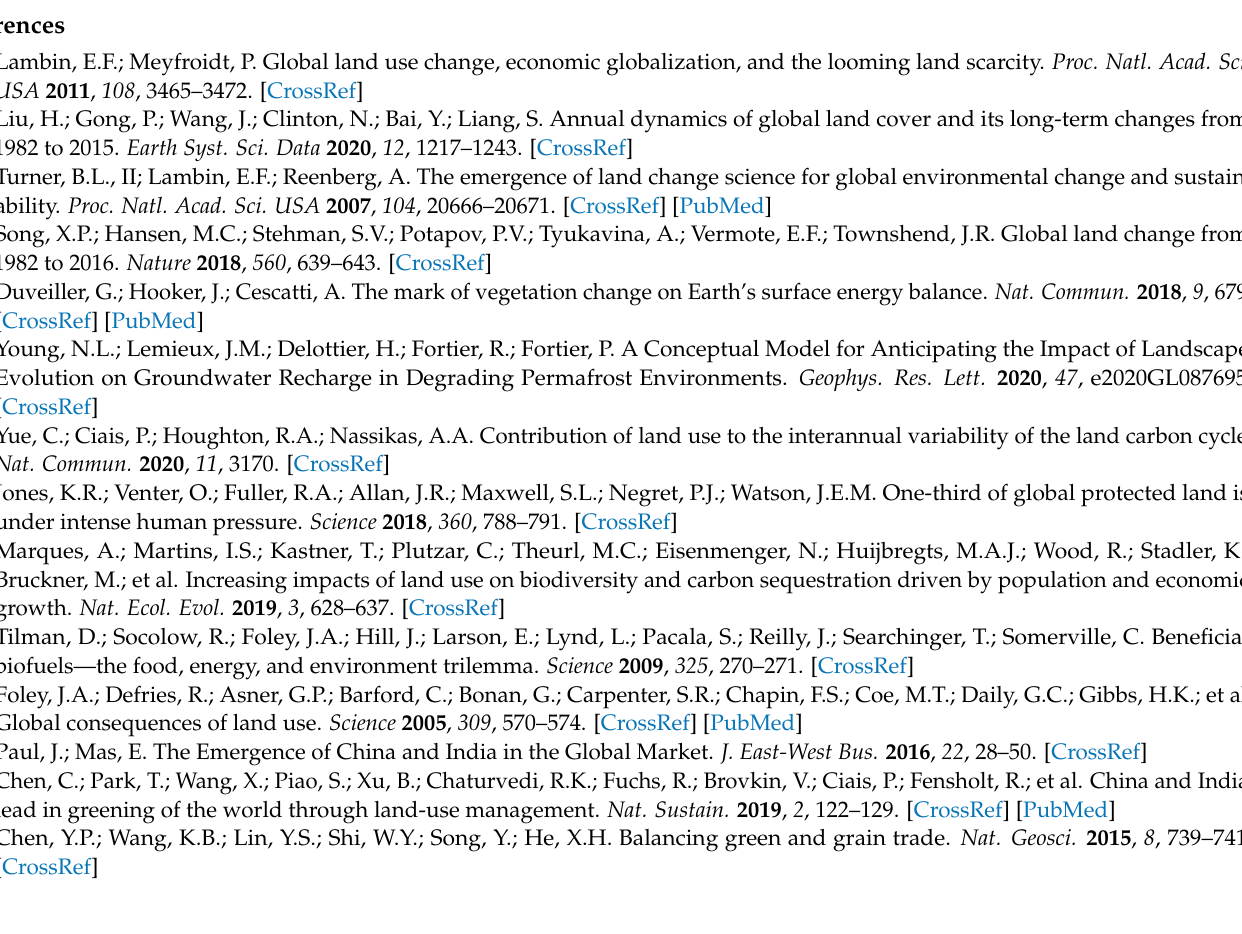
accuracy, and bold numbers represent correctly classified ones; Table S4: Test results for different classification methods; Table S5 Land use/cover datasets for comparison; Table S6: List of related land use/cover mapping